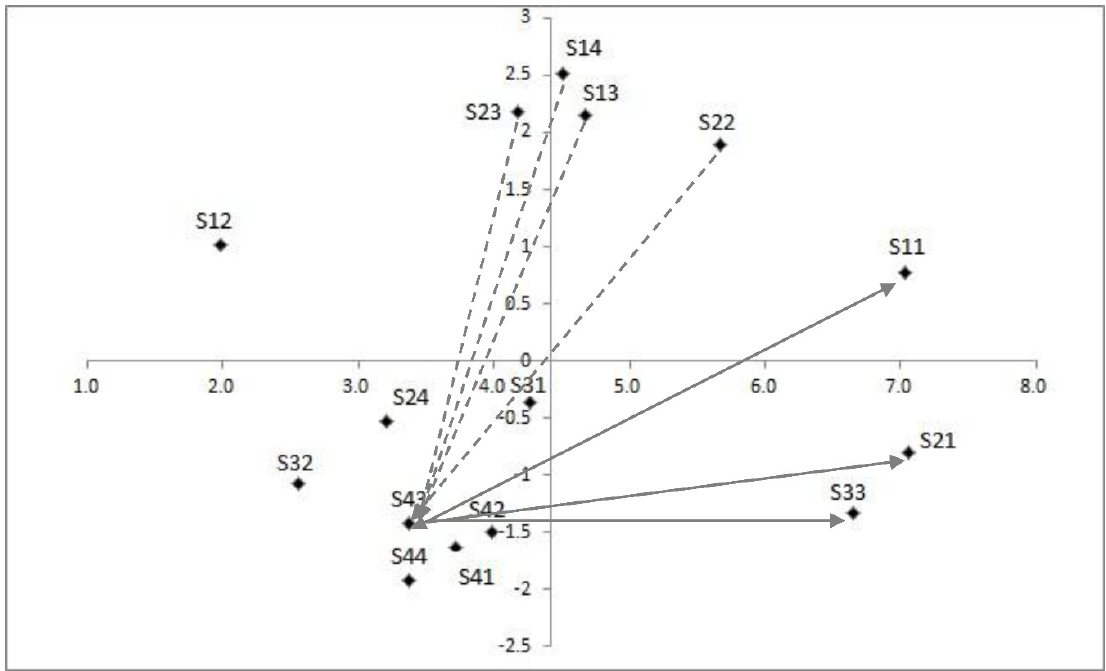
Figure A14. Casual Diagram between S43 and Other